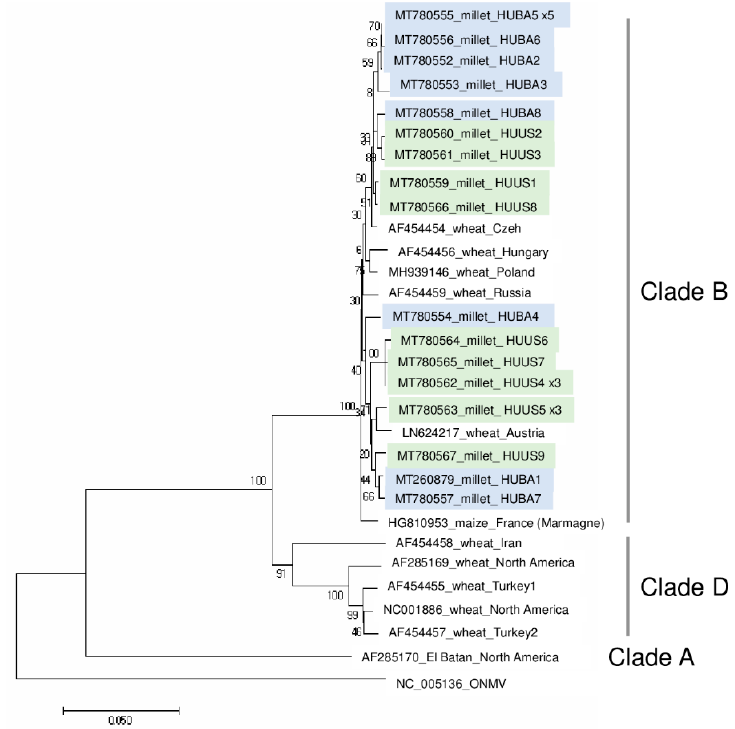
Figure 1. Results of the wheat streak mosaic virus (WSMV) detection by sRNA high-throughput sequencing (HTS). ( a ) Genome organization of WSMV, highlighting its coding regions and the position of the primers that were used in the RT-PCR. ( b , d ) show coverage of the genome by the sequenced virus-specific sRNA reads at Budos-arok (BA) and Ujmajor-susnyas (US), respectively. The blue color shows sRNA in sense, while the red color shows sRNAs in antisense orientation. ( c , e ) show the size distribution of the sequenced, WSMV-specific sRNA reads at BA and US, respectively.